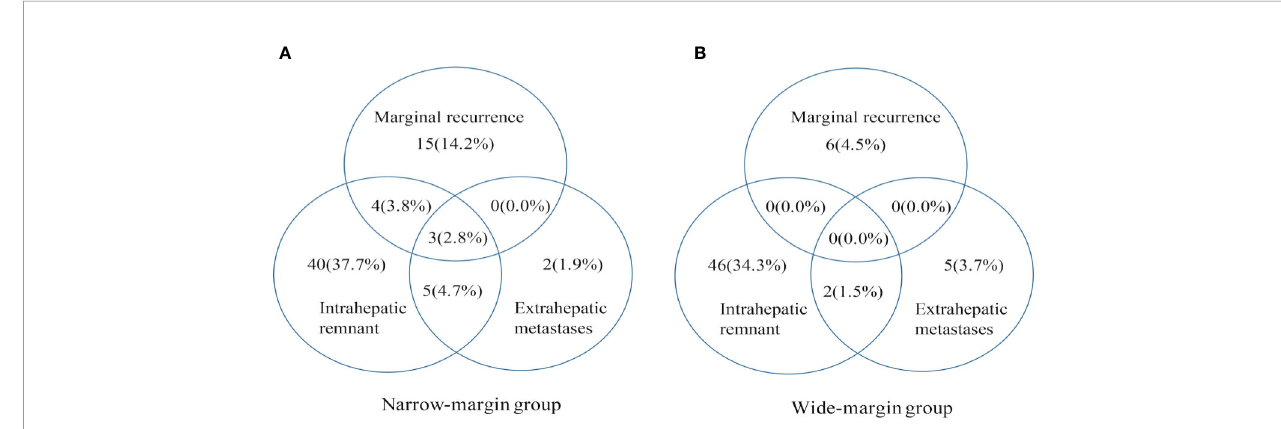
FIGURE 1 | Patterns of initial recurrence for hepatocellular carcinoma (HCC) patients in narrow-margin and wide-margin groups. Patterns of initial recurrence strati fi ed by marginal recurrence, intrahepatic remnant recurrence, and extrahepatic metastases. Values in parentheses are percentages. (A) Patterns of initial recurrence in the narrow-margin group. (B) Patterns of initial recurrence in the wide-margin group.